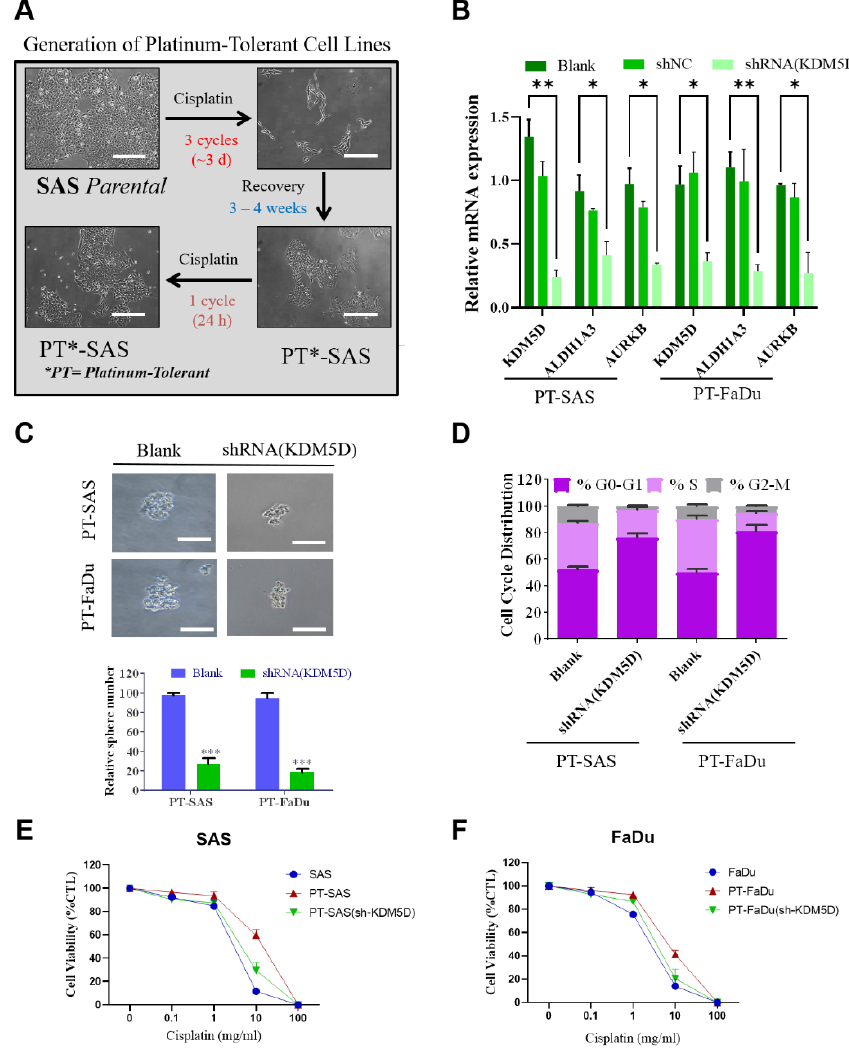
Figure 4. KDM5D promotes the generation of platinum-tolerant persister cells. ( A ) Brief schematic figure shows the steps to generate cisplatin-tolerant persister cells. Parental HNSCC cells were treated with a short-course of cisplatin treatment followed by a ‘drug-holiday’ or recovery stage and a final cisplatin course. At the end of this stage, the HNSCC cells were relatively viable and exhibited increased platinum tolerance. ( B ) KDM5D knockdown significantly reduced the expression levels of AURKB and ALDH1A3 in both SAS and FaDu persister cells, indicating that KDM5D regulates AURKB and ALDH1A3 expression. ( C ) KDM5D knockdown significantly reduced tumor sphere formation in both PT-SAS and PT-FaDu cells. ( D ) Both platinum-tolerant persister HNSCC cells exhibited cell cycle arrest, as indicated by a significant increase in the G0/G1 subpopulation and a decrease in S and G2/M subpopulations. ( E , F ) KDM5D silencing re-sensitized platinum-tolerant persister cells upon cisplatin treatment, indicating that KDM5D plays a crucial role in promoting platinum tolerance in HNSCCs. Significance level: * p < 0.05; ** p < 0.01, *** p < 0.001. Scale bar: 100 µ